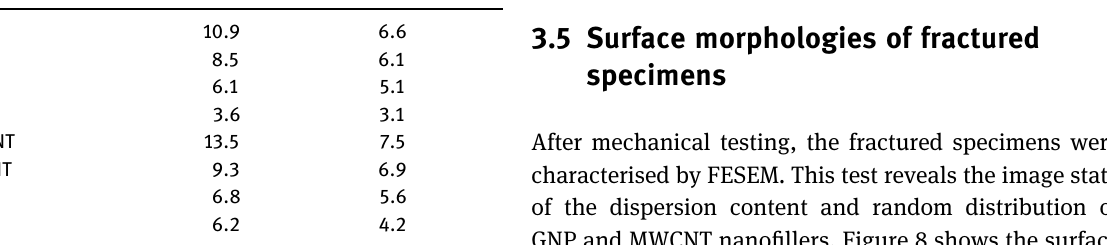
Table 3: GF value of GNP - glass and MWCNT - glass composites Nano fi ller loading ( wt%